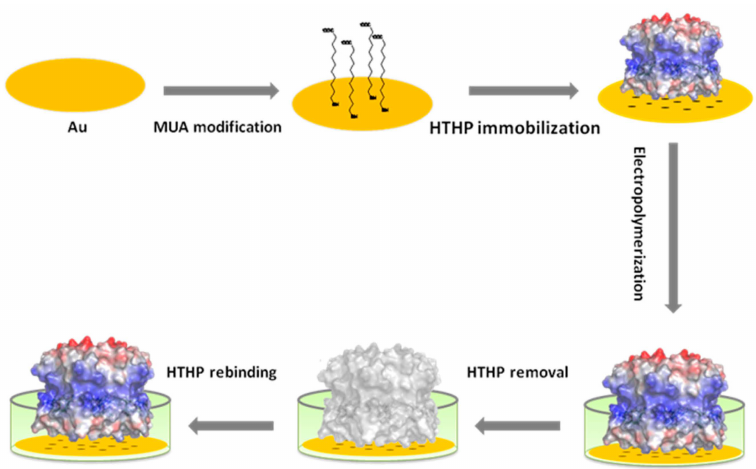
Figure 1. Schematic representation of the MIP preparation on a negatively charged thiol terminated SAM; Red: negatively charged region of HTHP, blue: positive